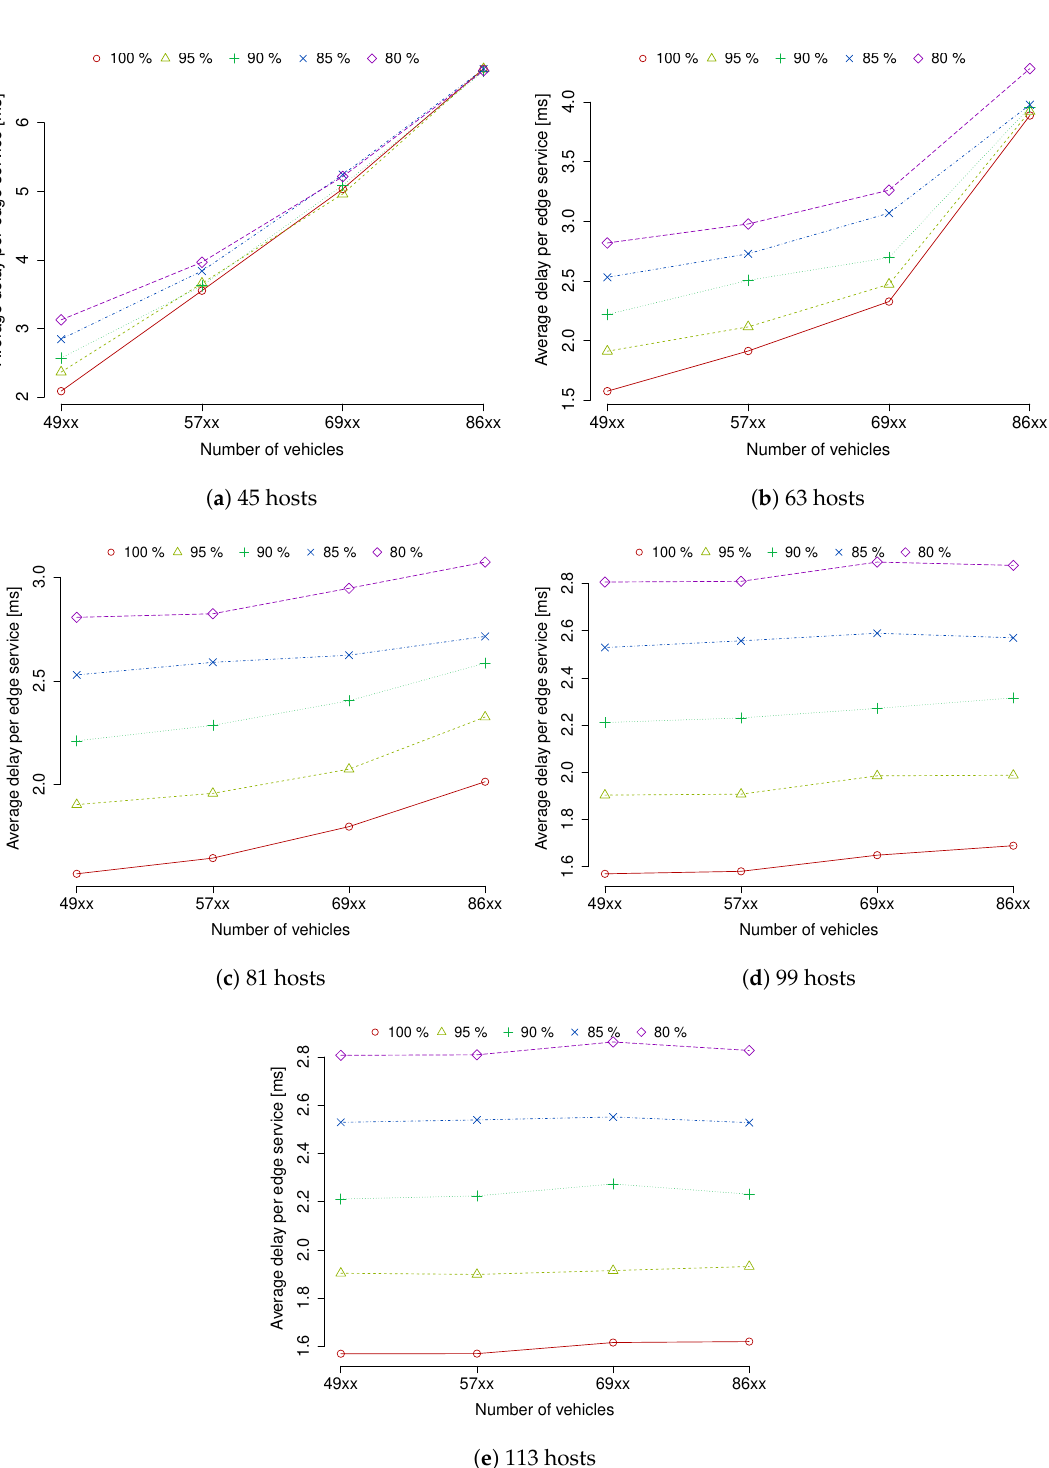
Figure 7. Average delay per MEC service considering the prediction